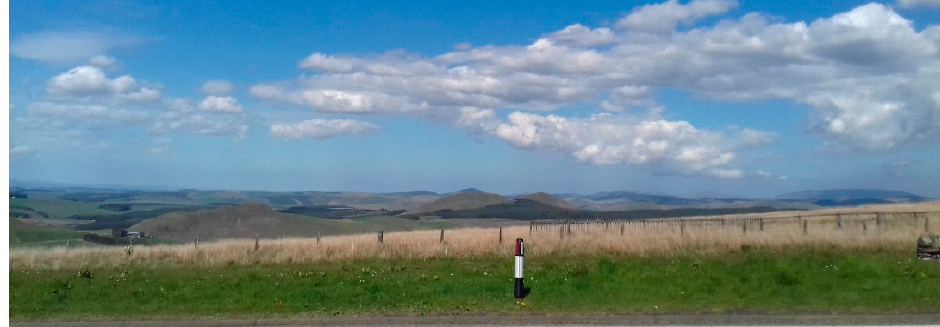
Figure 4. The view looking east across to the Cheviots at Carter Bar, Scotland. Image, author’s own.